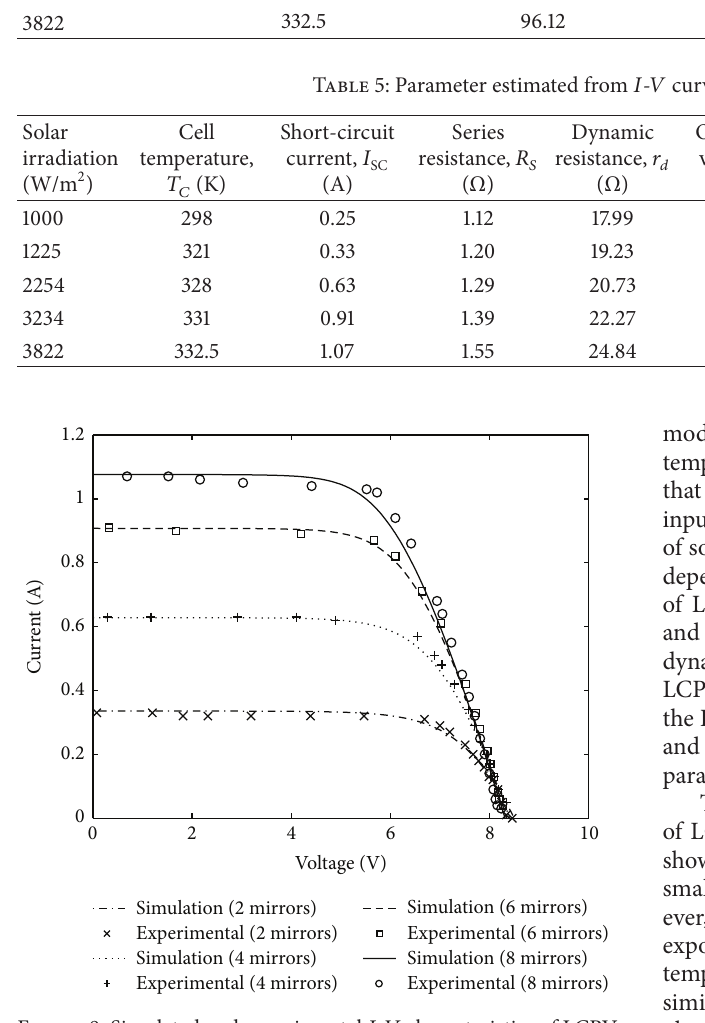
Figure 9: Simulated and experimental 𝐼 - 𝑉 characteristics of LCPV system under